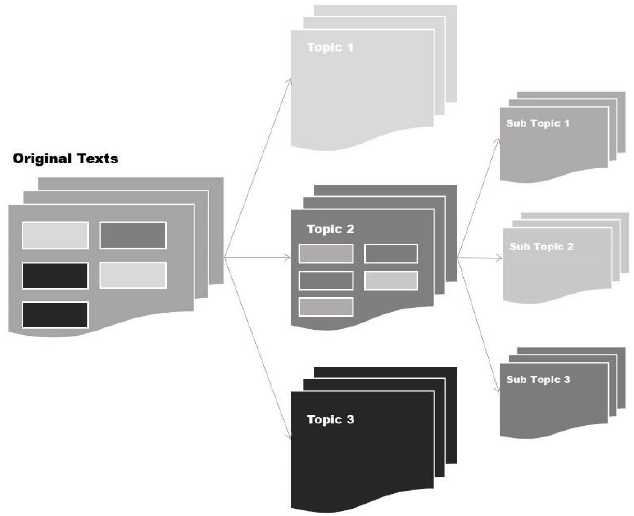
Figure 3. The logic of hierarchical LDA (hLDA) (adapted from [68]).